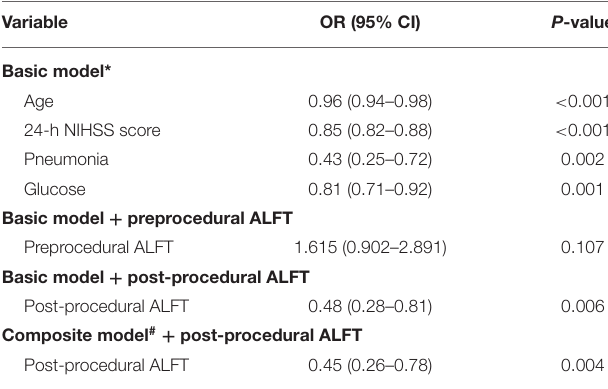
TABLE 2 | Multivariable logistic regression for predicting favorable